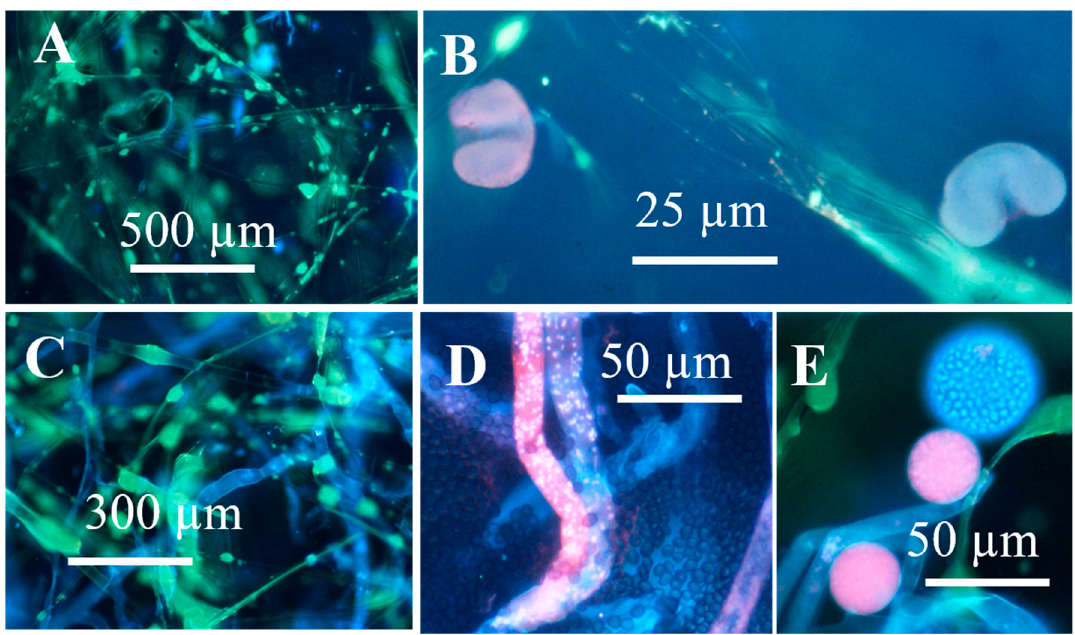
Figure 4. Micrographs of an inlet air filter stained with the viability stain Hoechst 33342 + propidium iodide. The upper row shows the dry filter exhibiting glass fibre and pollen grains ( A , B ). The lower row shows the filter after moisturizing for 48 h. The pictures show actively growing fungal structures ( C – E ) and dormant conidia ( D ).